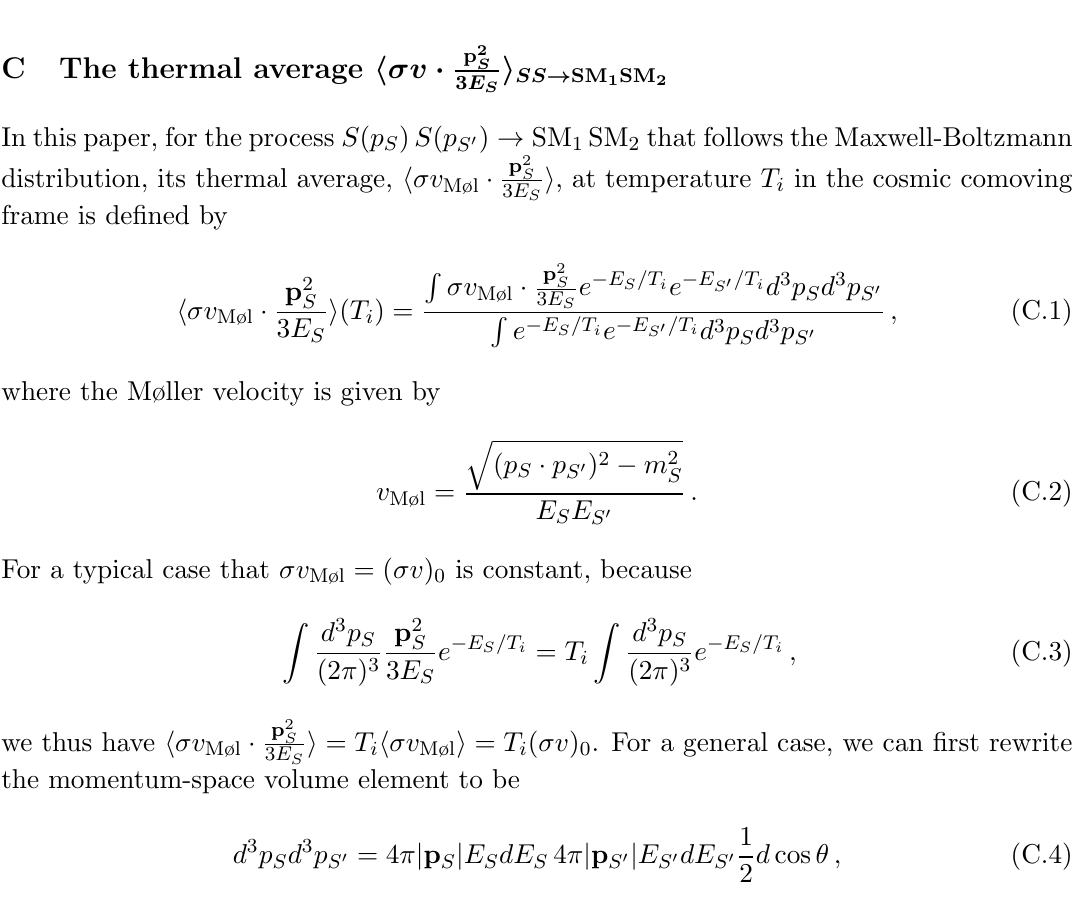
Figure 10 . Feynman diagrams for the annihilation of the hidden scalar pair into SM particles. The results are relevant to the chemical equilibrium between the hidden sector and thermal bath in the early